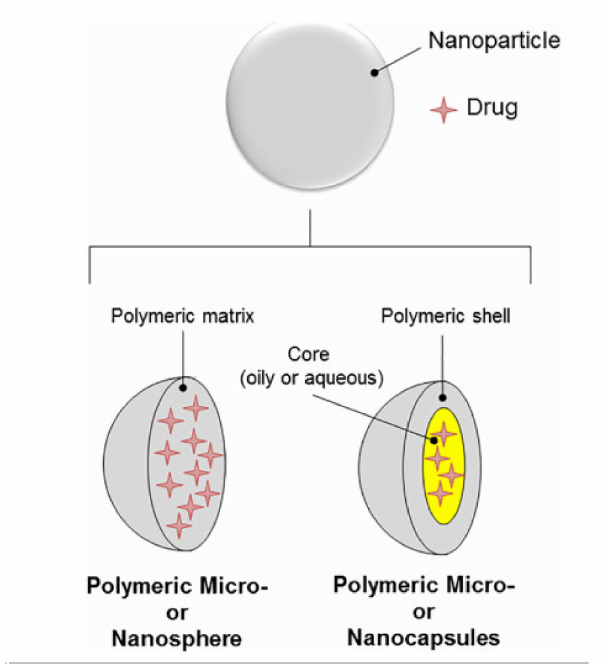
Figure 2. Schematic difference between polymeric micro- or nanocapsule and micro- or nanoparticle drug delivery systems [22]. Reproduced with permission from Elsevier